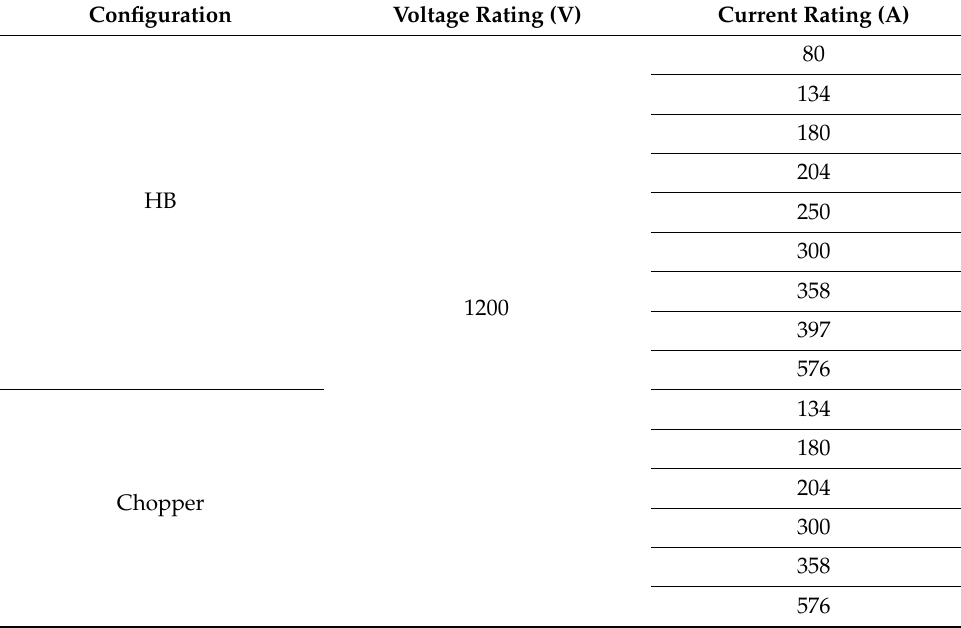
Table 16. Commercial SiC MOSFET modules by Rohm